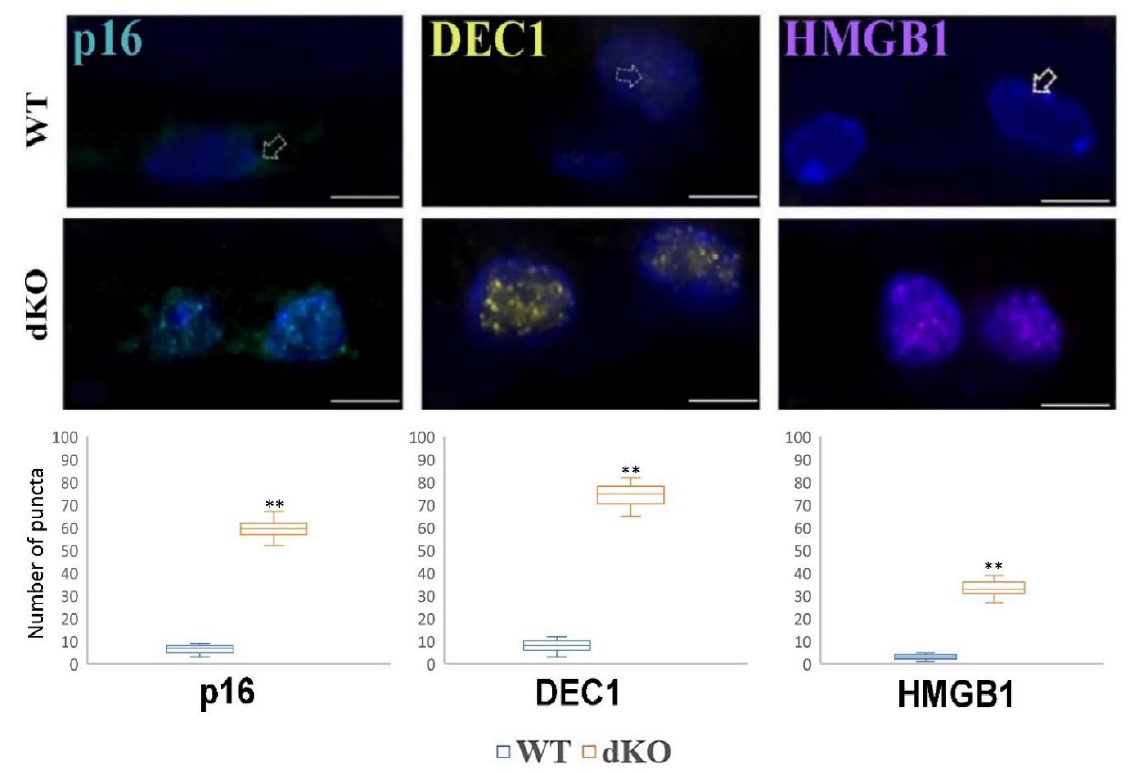
Figure 7. Confocal microscopy analysis of the immunoreactivity of the senescence markers p16, DEC1 and HMGB1 in the retinal pigment epithelium (RPE) of one-year-old NFE2L2/PGC-1 α dKO mice as compared with their WT counterparts. Semi-quantitative comparative densitometric analysis performed by ImageJ of the immunoreactivity of the markers in 1- µ m parasagittal sections of RPE. Alexa Fluor secondary antibodies were used to detect senescence markers. DAPI was used to stain the nuclei of RPE cells. Scale bar: 5 µ m. Arrows indicate staining of senescence markers in the RPE. ** p < 0.001 (Mann-Whitney U-test).